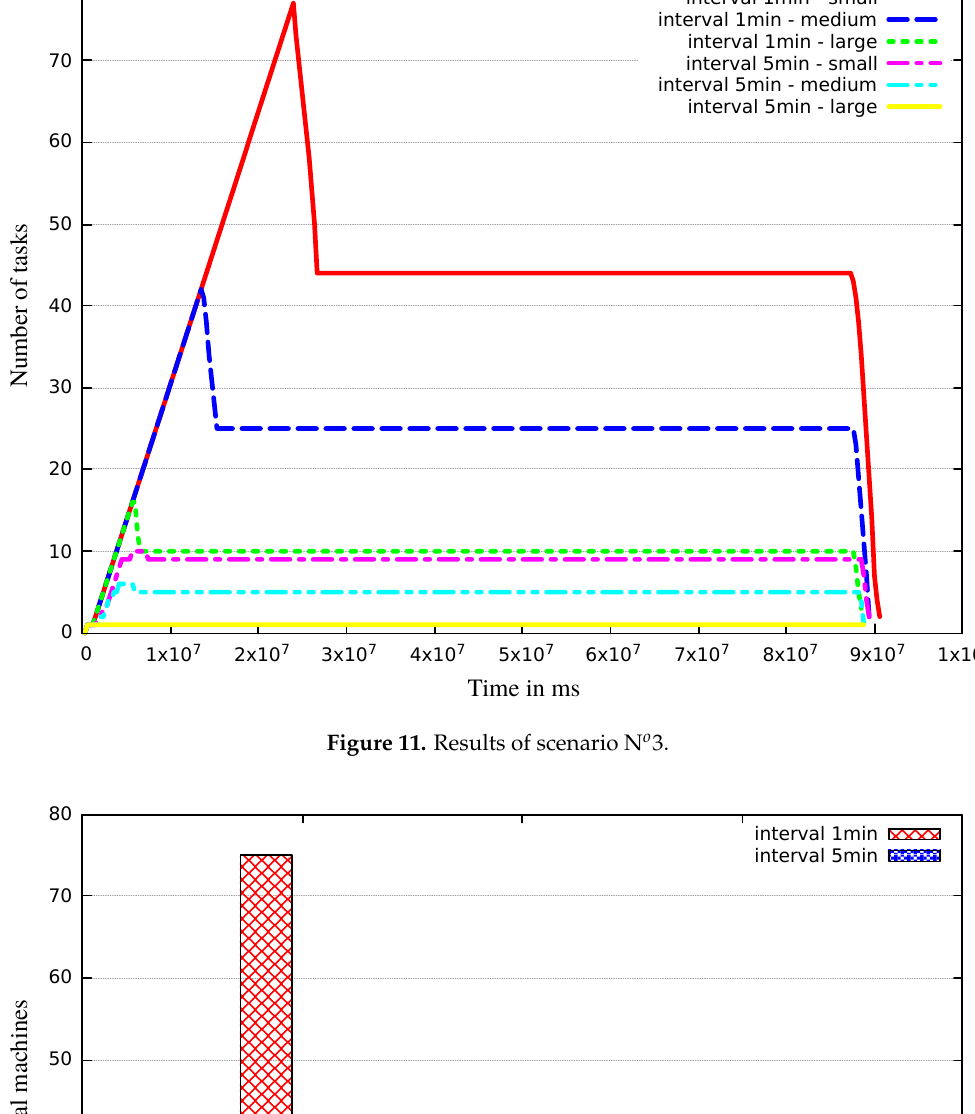
Figure 11. Results of scenario N o 3.